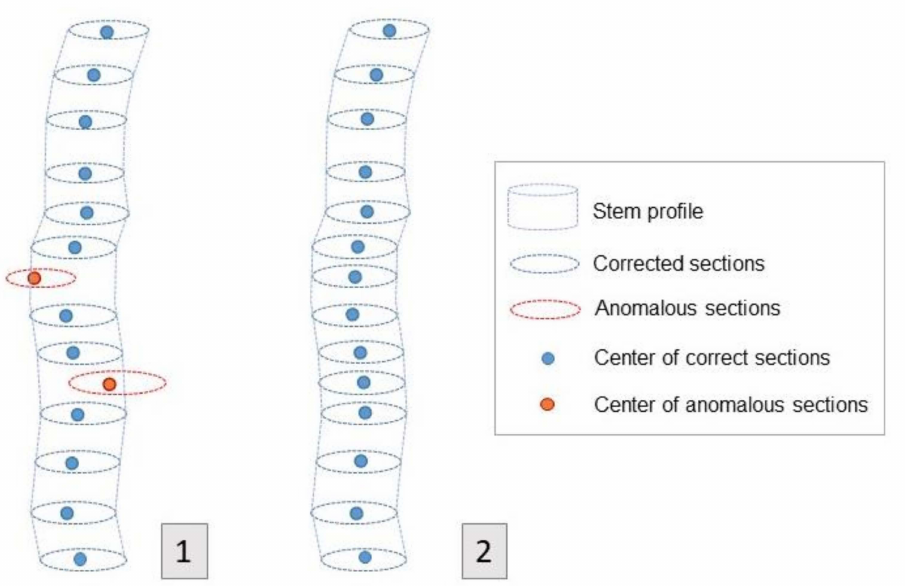
Figure 2. ( 1 ) Stem sections, defined by their center ( X , Y , Z ) and radius, automatically calculated by the algorithm presented in [32,33]. In red, the sections labelled as anomalous by the algorithm. ( 2 ) Stem sections after the correction of the anomalous